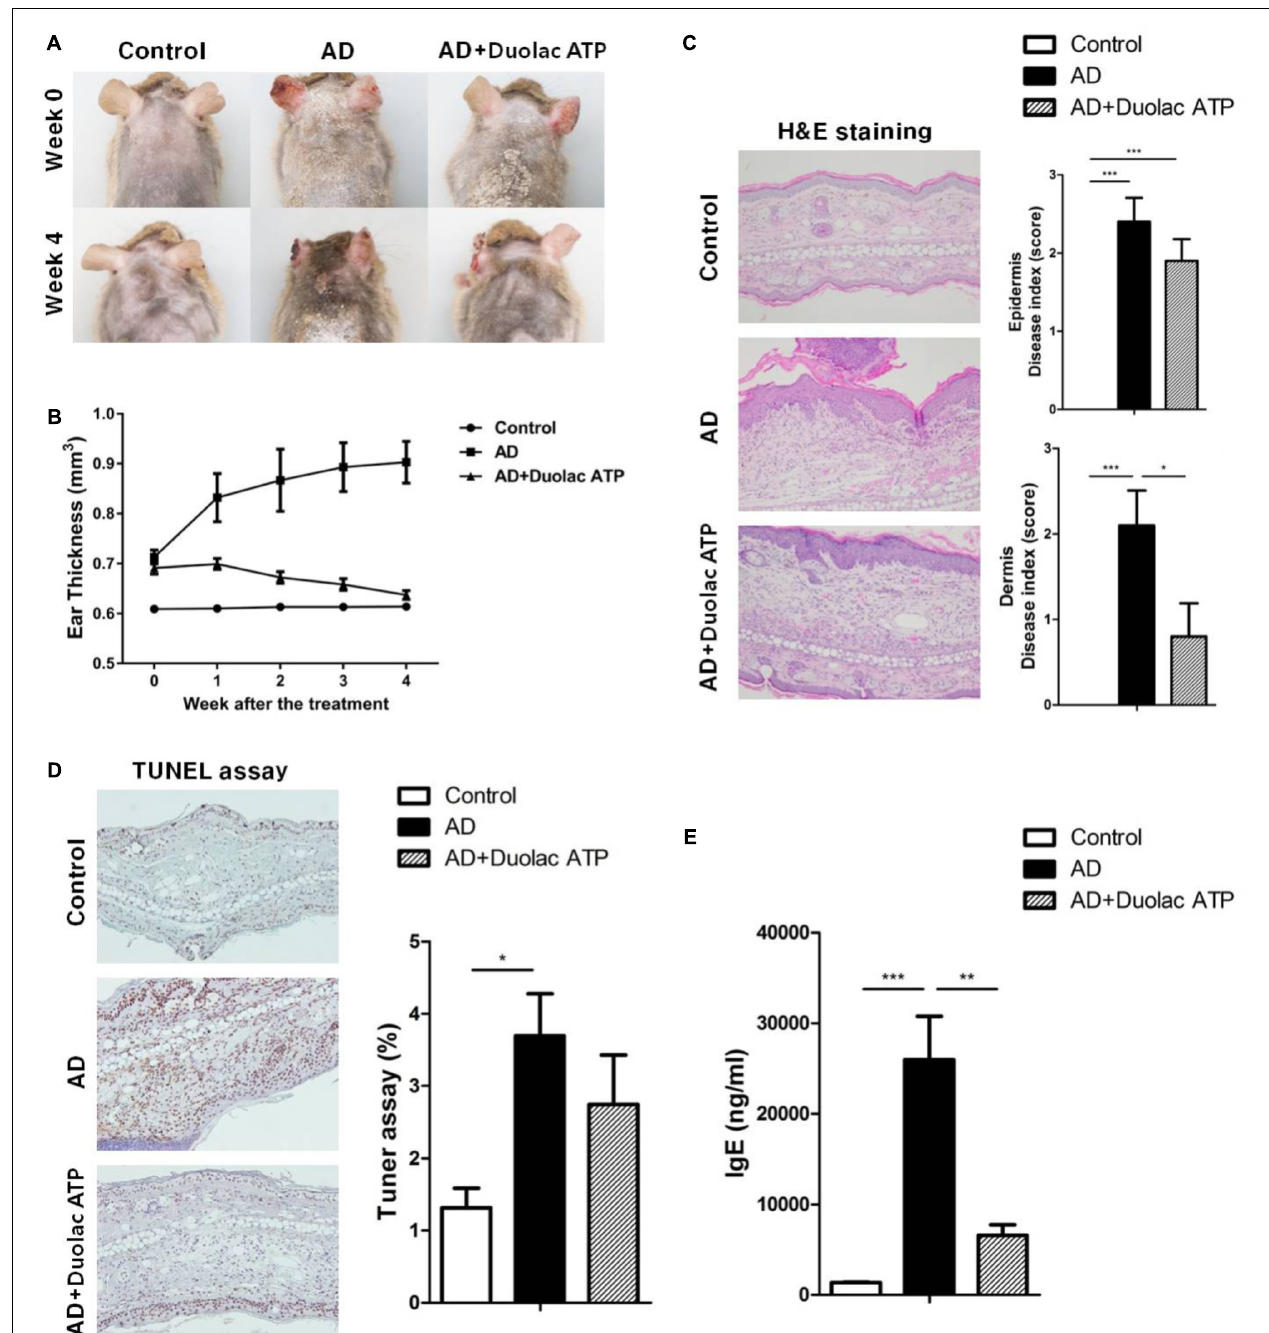
FIGURE 3 | Amelioration of AD symptoms in mice treated with Duolac ATP. NC/Nga mice were sensitized by exposing them to HDM extract twice a week for 3 weeks. PBS or Duolac ATP was then orally administered for 4 weeks. (A) Atopic symptoms and (B) ear thickness were scored every week for the last 4 weeks. At the end of the experiment, (C) the results of the histological analysis of cell infiltration by H&E staining (left panel, one representative from 10 samples) and the epidermis and dermis index score (right panel) were examined. (D) TUNEL assay on dermis samples (left panel, one representative from 10 samples) and the percentage of the plot (right panel) are shown. (E) Blood samples were acquired, and serum IgE levels were measured by ELISA. ∗ P < 0.05, ∗∗ P < 0.01, ∗∗∗ P < 0.001 using one-way ANOVA with Tukey’s multiple comparison test. Bars indicate mean ± SEM.